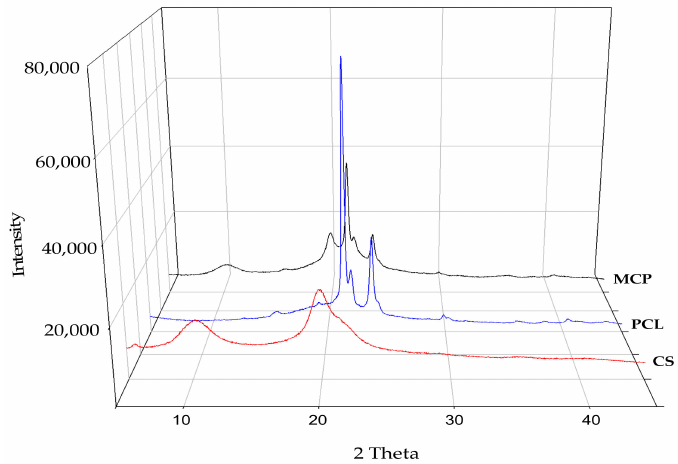
Figure 3. XRD patterns of PCL, CS and